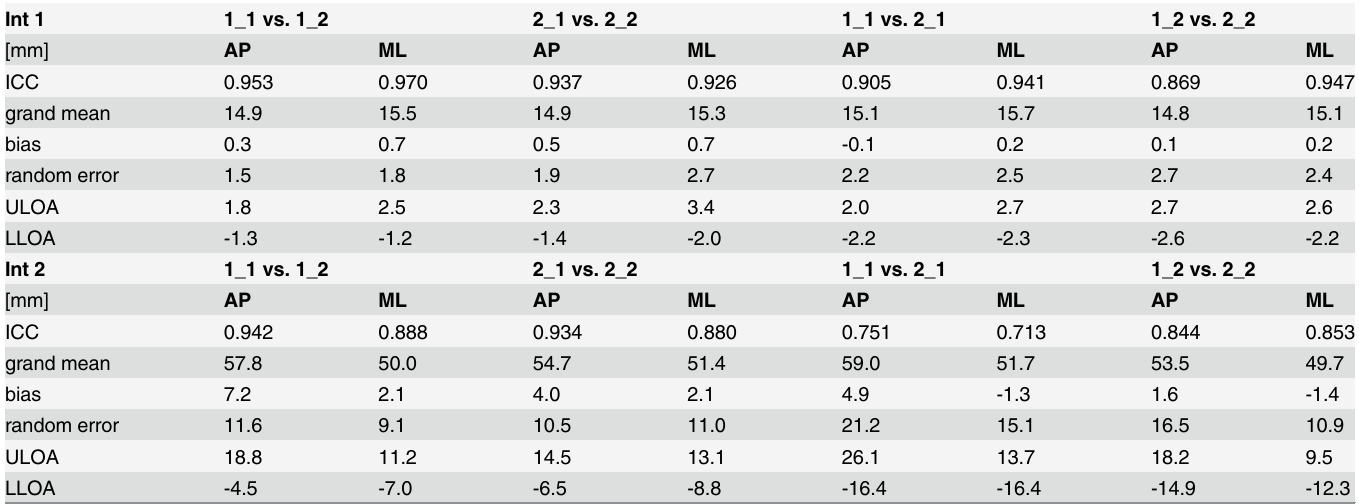
Table 2. Overview of ICCs and parameters implemented in the analysis of Bland-Altman plots. Depicted are the grand mean (mean of both measure- ment sessions), bias, random error component and upper/lower limits of agreement (ULOA/LLOA, respectively) for inter- and intra-day comparisons of all intervals in the AP and ML